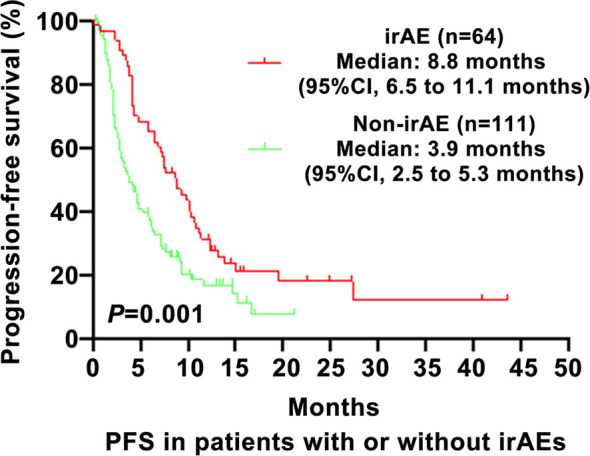
Impact of immune-related adverse events (irAEs) on progression-free survival (PFS). PFS, progression-free survival; CI, confidence interval; irAE, immune-related adverse events; P-values <0.05 were considered statistically significant.